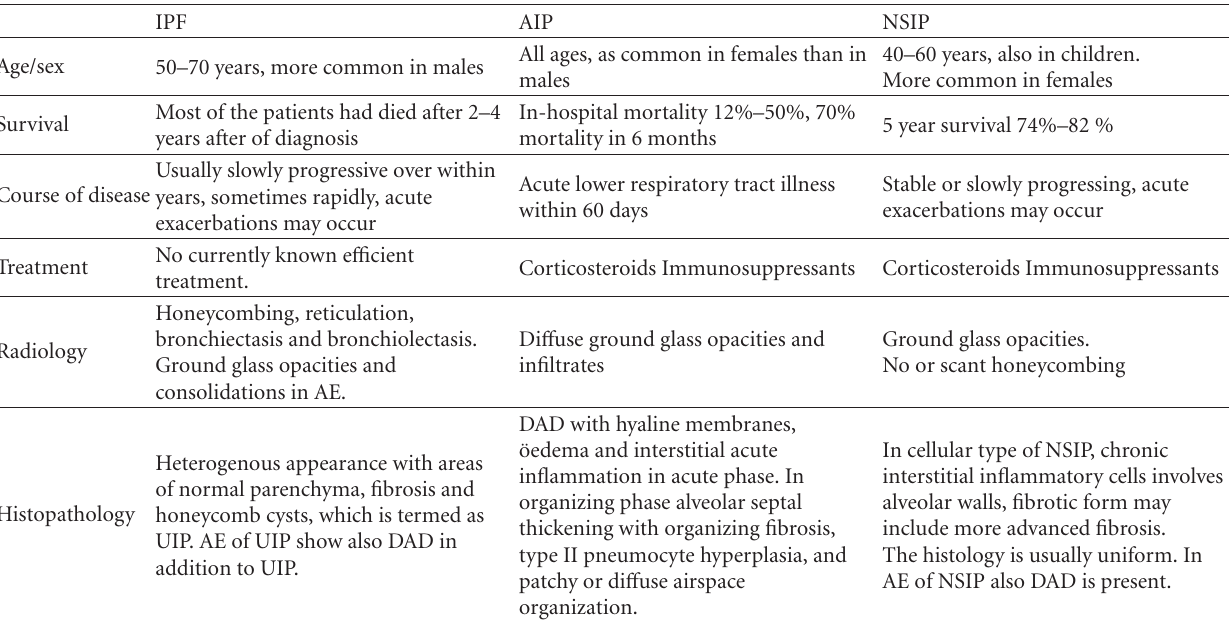
Table 2: Idiopathic interstitial pneumonias that may behave